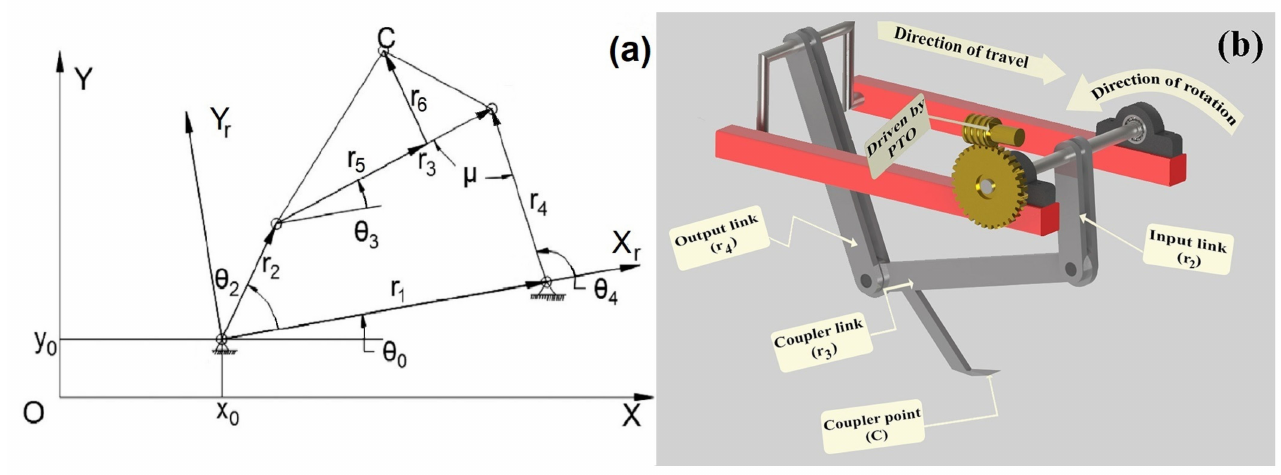
Figure 4. Coupler point C on the coupler link of a four-bar mechanism: ( a ) a schematic view, reproduced from ref. [56] with permission from Copyright Frontiers Media S.A., and ( b ) a schematic 3D